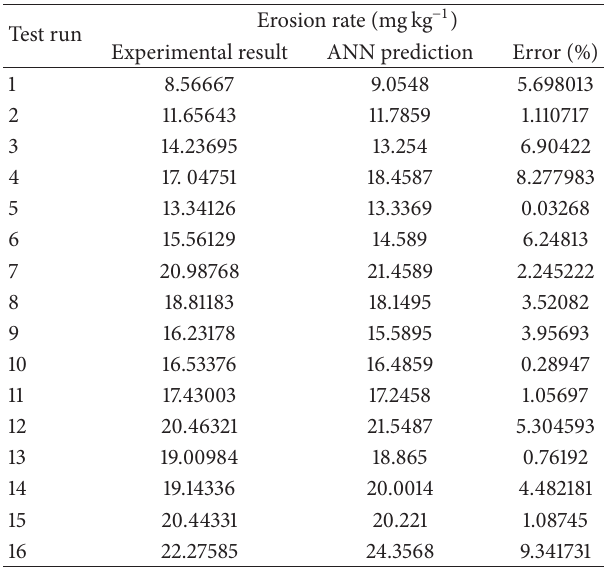
Table 8: Percentage error between experimental result and ANN prediction.